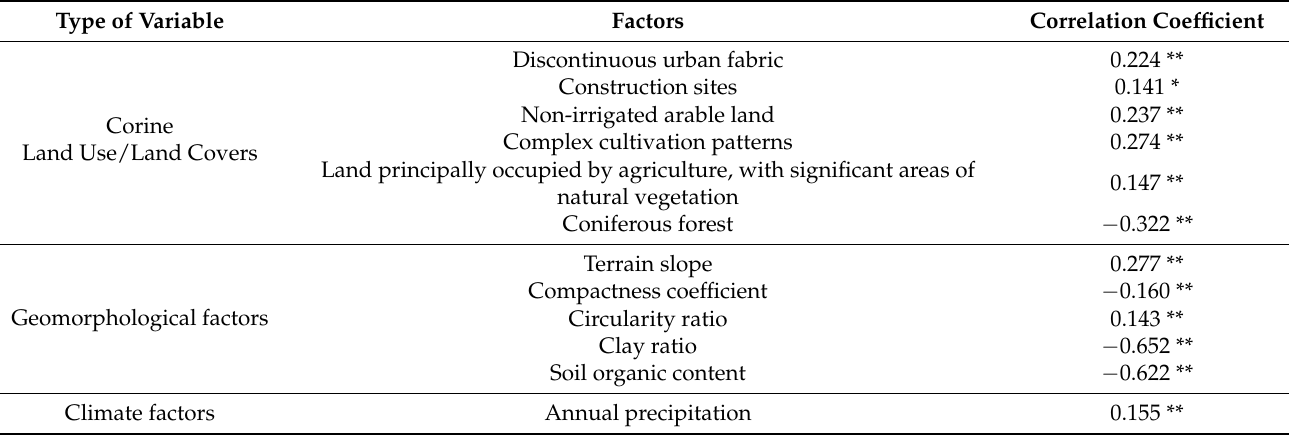
Table 2. Pearson correlation test ( p ≤ 0.05 and p ≤ 0.01 for n = 327) for the relationship between the soil erosion rates and the Corine land use/land cover types, soil intrinsic factors, and geomorphological features at catchment scale. Type of